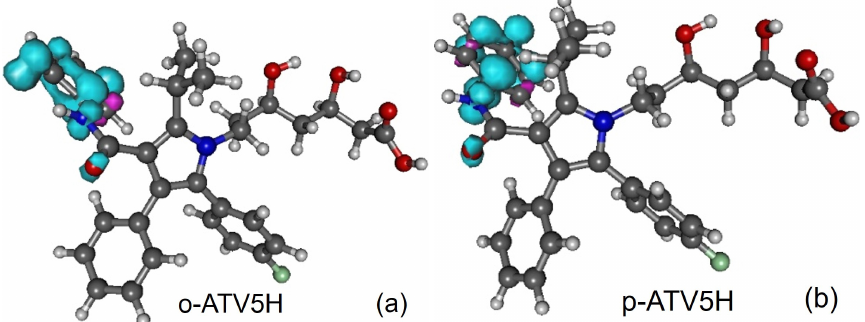
Figure 5. Spin densities of radicals generated from atorvastatin ortho- and para-hydroxy metabolites by H-atom abstraction at position 5-OH: ( a ) o-ATV5H and ( b ) p-ATV5H. Figure generated using GABEDIT